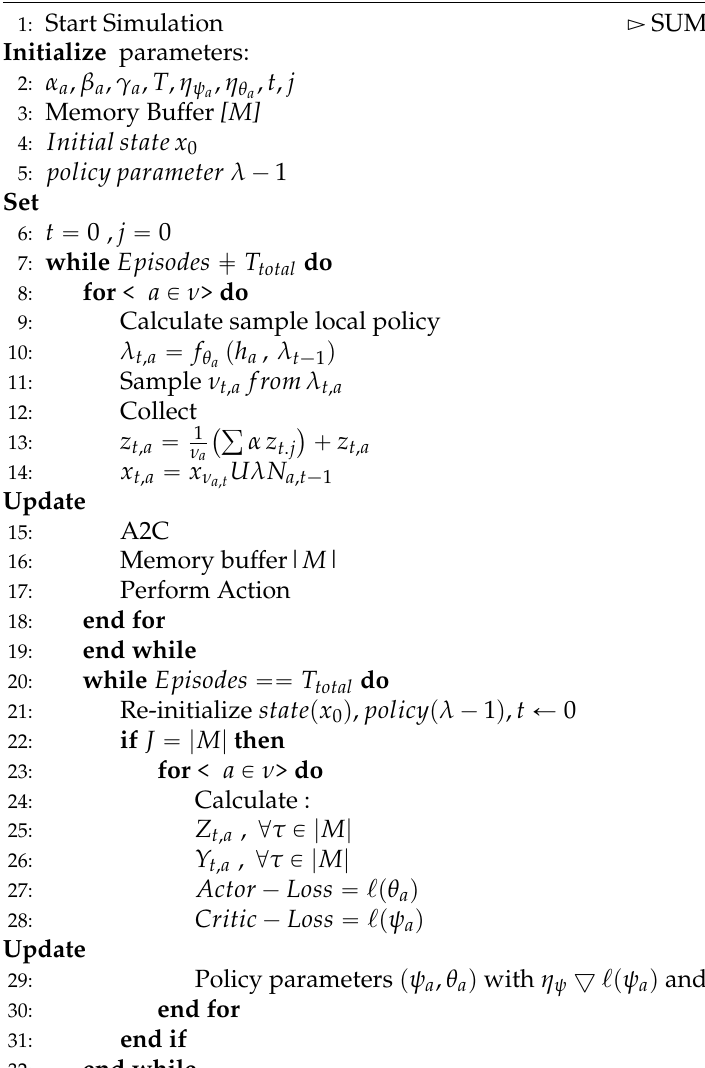
Algorithm 2 Multi-Agent Advantageous Actor Critic (MA2C) Algorithm for MARL